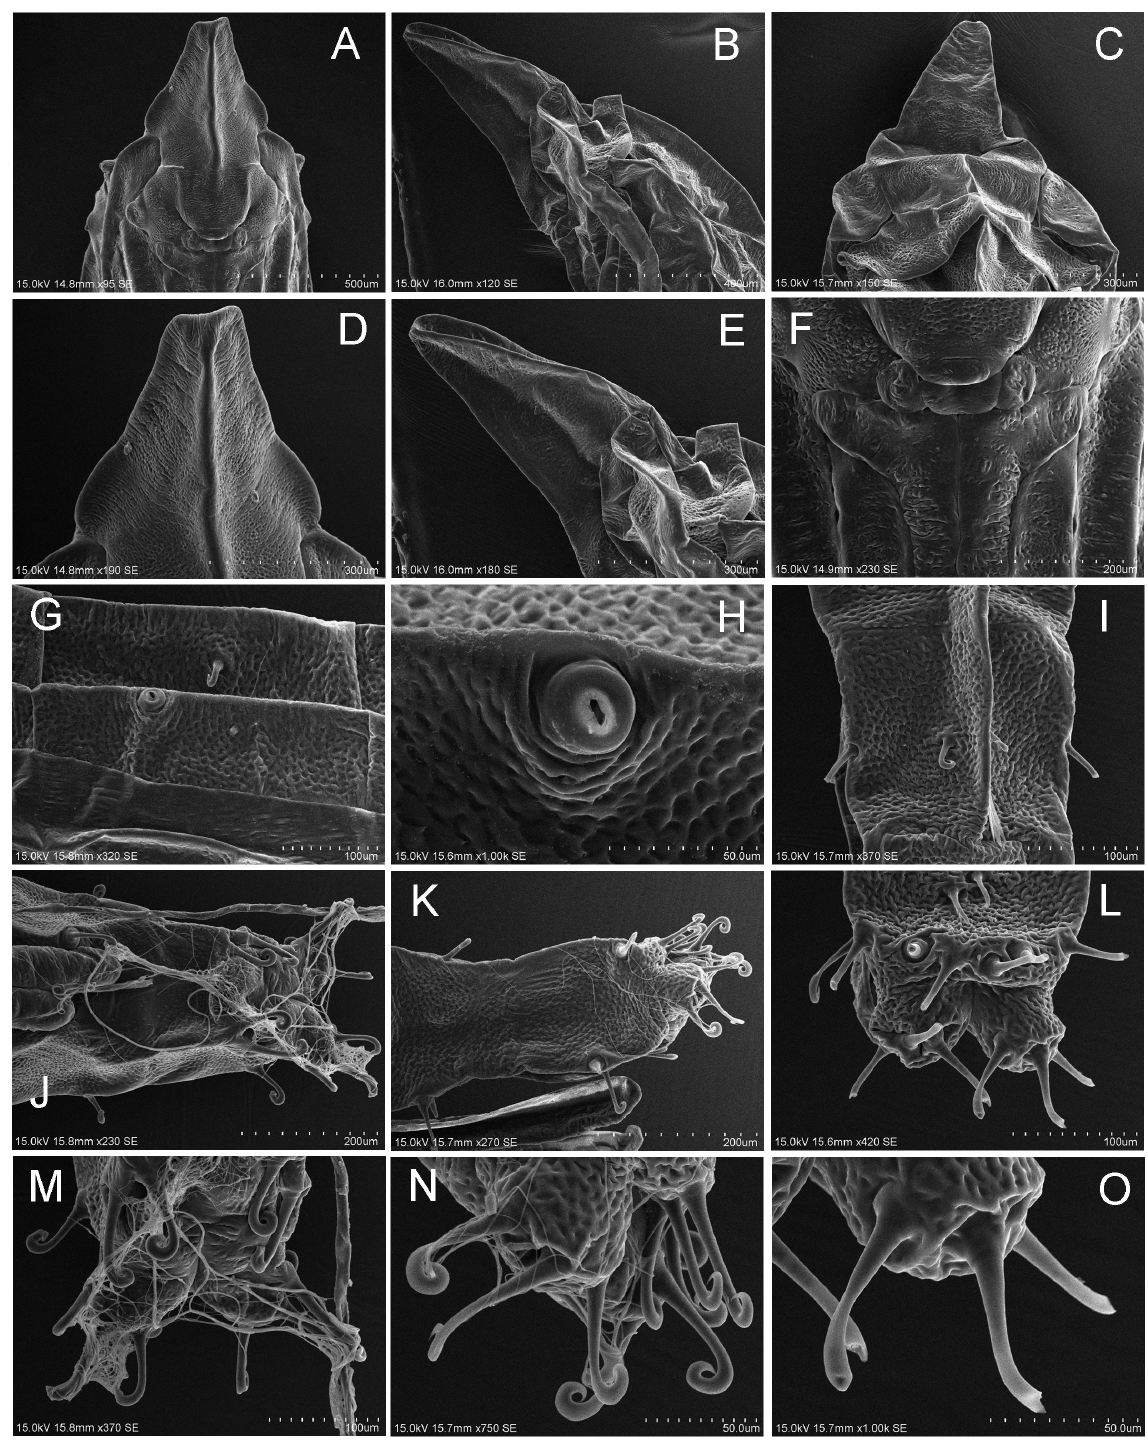
Fig. 17. SEMs of pupa of Bedellia somnulentella Zeller, 1847 (OPU-IN-LE2018IV0038–0039). A . Head, ventral view. B . Lateral view. C . Dorsal view. D . Frontal process, ventral view. E . Same, lateral view. F . Face, ventral view. G . Seta and spiracle of abdomen, lateral view. H . Spiracle. I . A7, dorsal view. J . A7–A10, dorsal view. K . Same, lateral view. L . Dorsal view. M . Setae of A10, ventral view. N . Same, lateral view. O . Dorsal